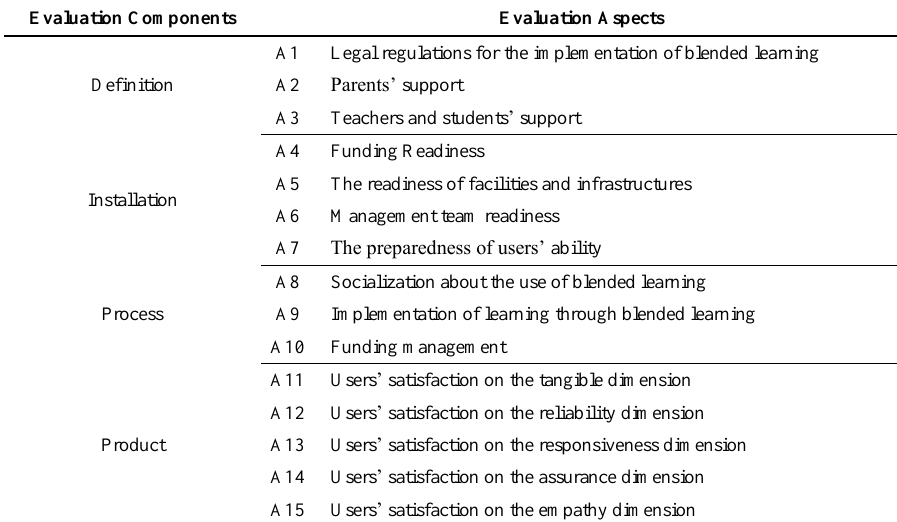
Table 1. Evaluation aspects of the Discrepancy model that was used to evaluate the blended learning implementation at IT vocational schools in Bali.